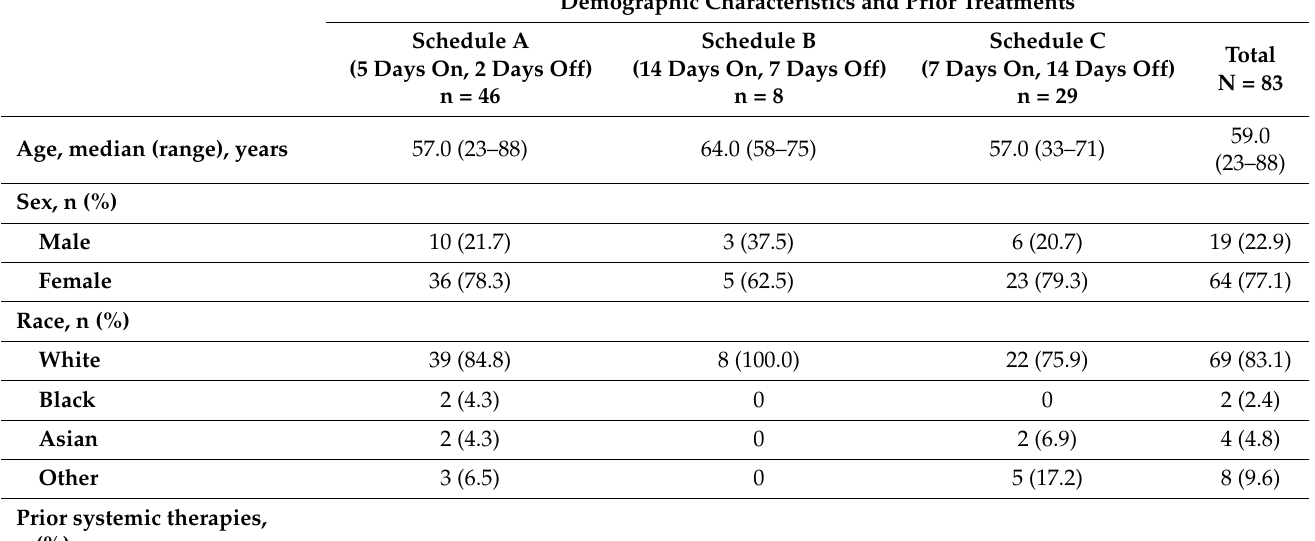
Table 1. Baseline clinical and demographic characteristics by treatment schedule for BMS-986158 monotherapy QD a